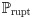
Visualization of ℙrupt for all AAAs in group 2.